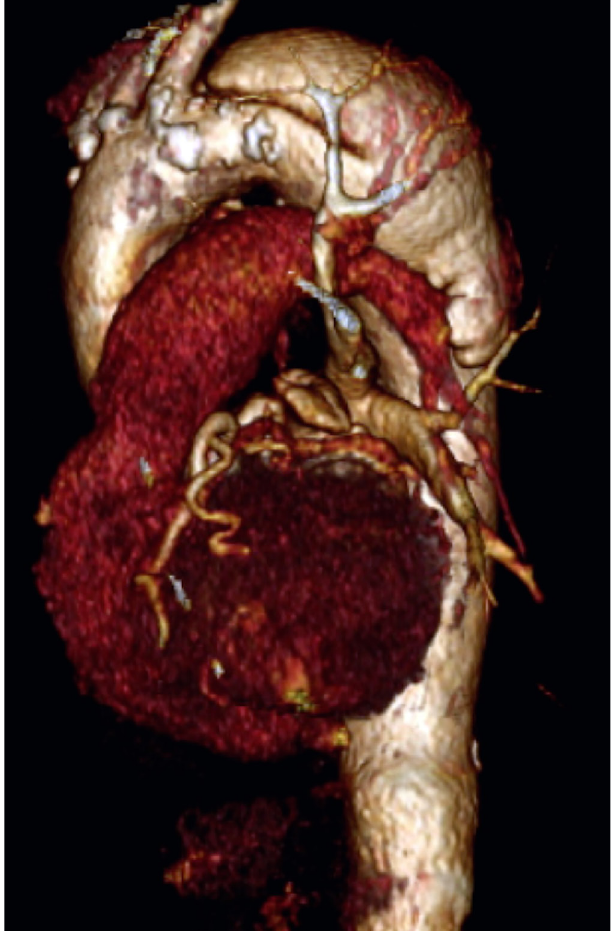
Fig. 1B - Tridimensional reconstruction of angiotomography of the aorta: